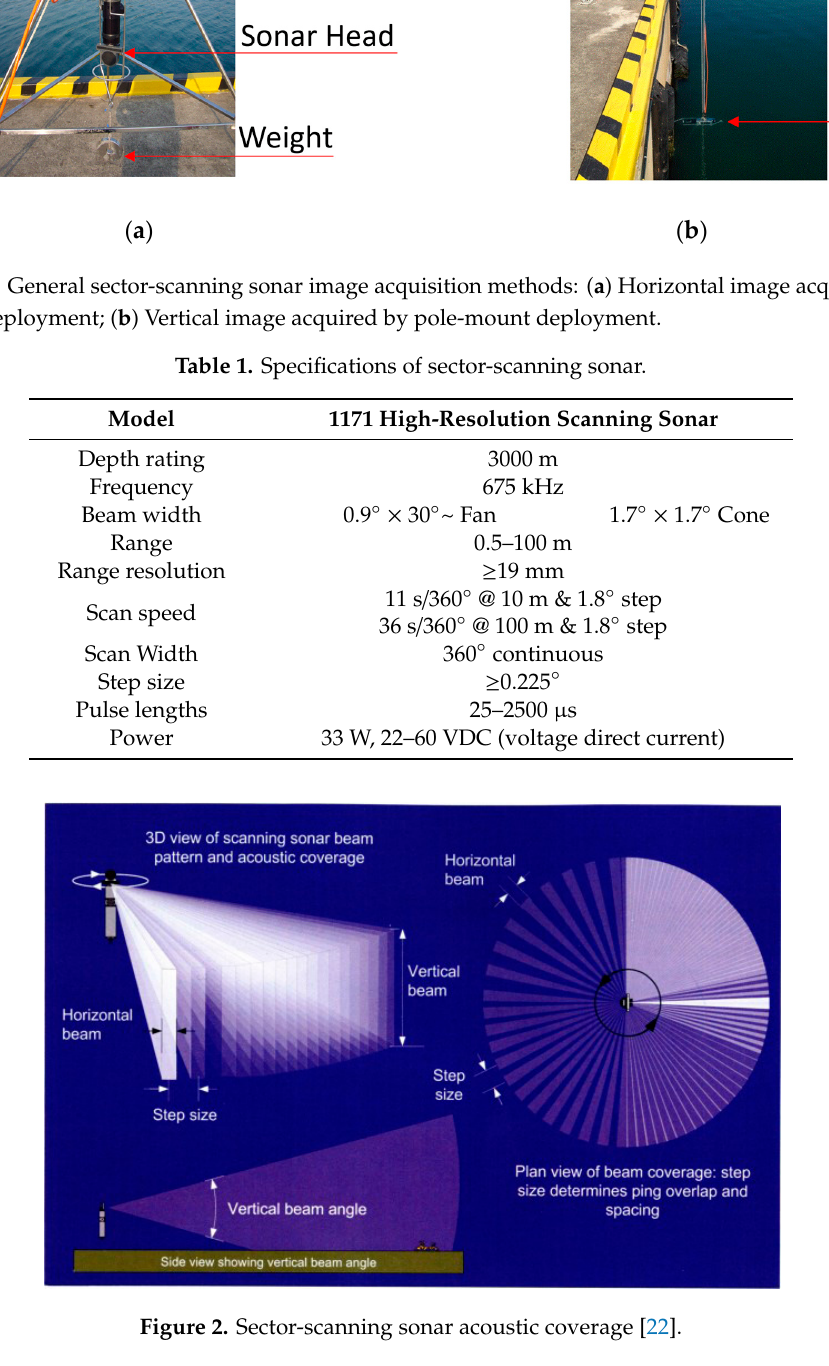
Figure 2. Sector-scanning sonar acoustic coverage [22].